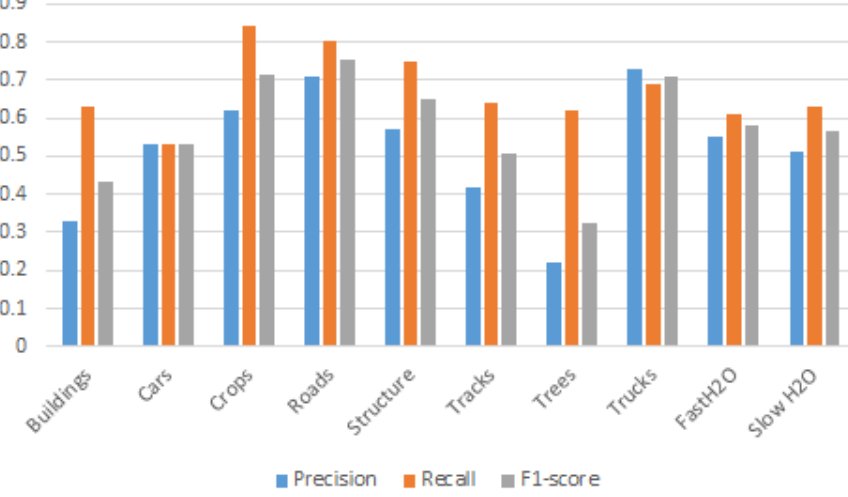
Figure 6. Results obtained with VGGNet for our datasets.